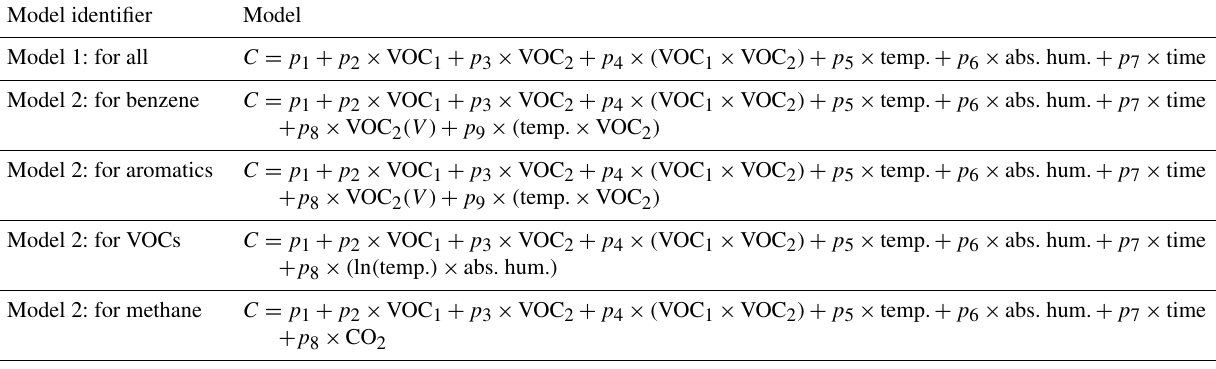
Model predictors: VOC 1 – Figaro 2600 R/R 0 ; VOC 2 – Figaro 2602 R/R 0 ; temp – temperature ( ◦ C); abs. hum. – absolute humidity; time – continuous time; VOC 2 (V) – Figaro 2602 voltage signal; CO 2 – carbon dioxide concentration (in this case from the reference data). C is the concentration value being solved for, either an individual or group of